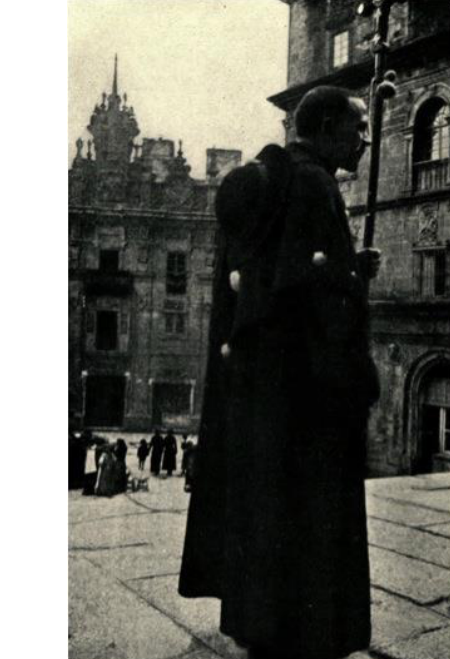
Unidentified photographer, A Pilgrim at Santiago , from Georgiana Goddard King, The Way of Saint James vol. 2 (New Y ork: G.P. Putnam’s Sons, 1920), page 483 (photo: